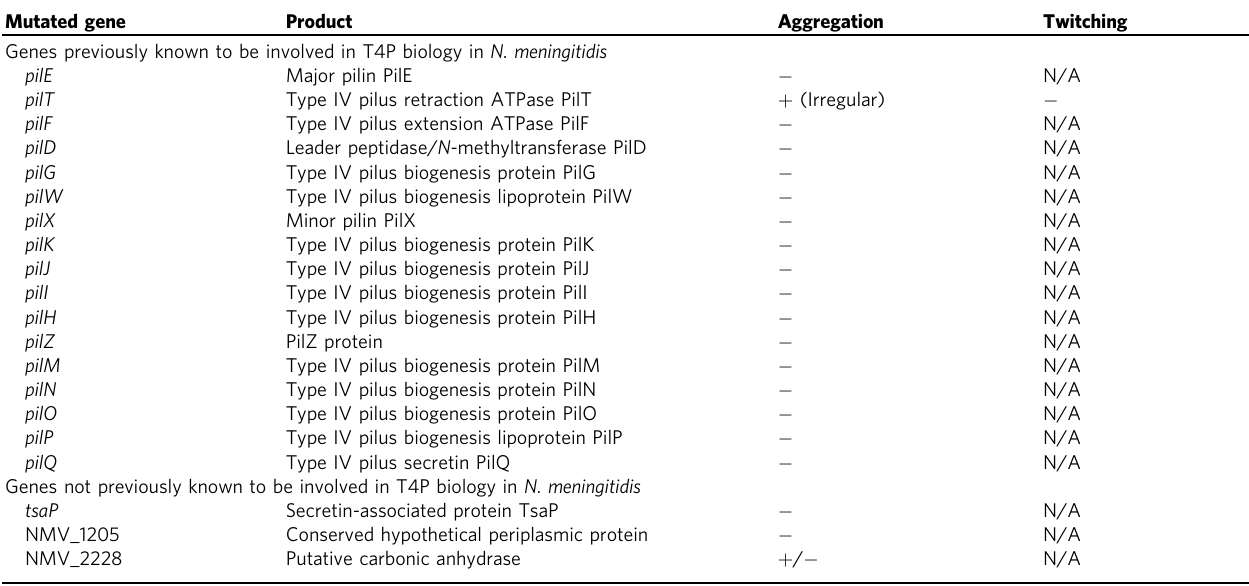
Table 2 Mutants in the complete NeMeSys 2.0 library of meningococcal mutants affected for two functions mediated by T4P: aggregation and twitching